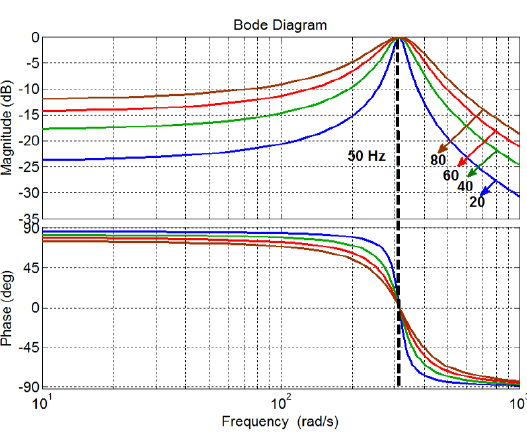
Figure 2. The block diagram of STF.